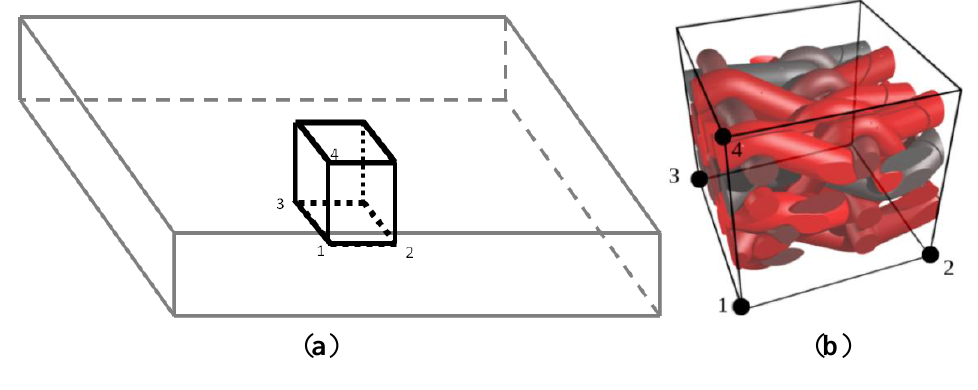
Figure 7. Representative volume element (RVE) controlling nodes using periodic boundary conditions. ( a ) RVE within a plate/shell structure; and ( b ) macroscopic loading control points of the